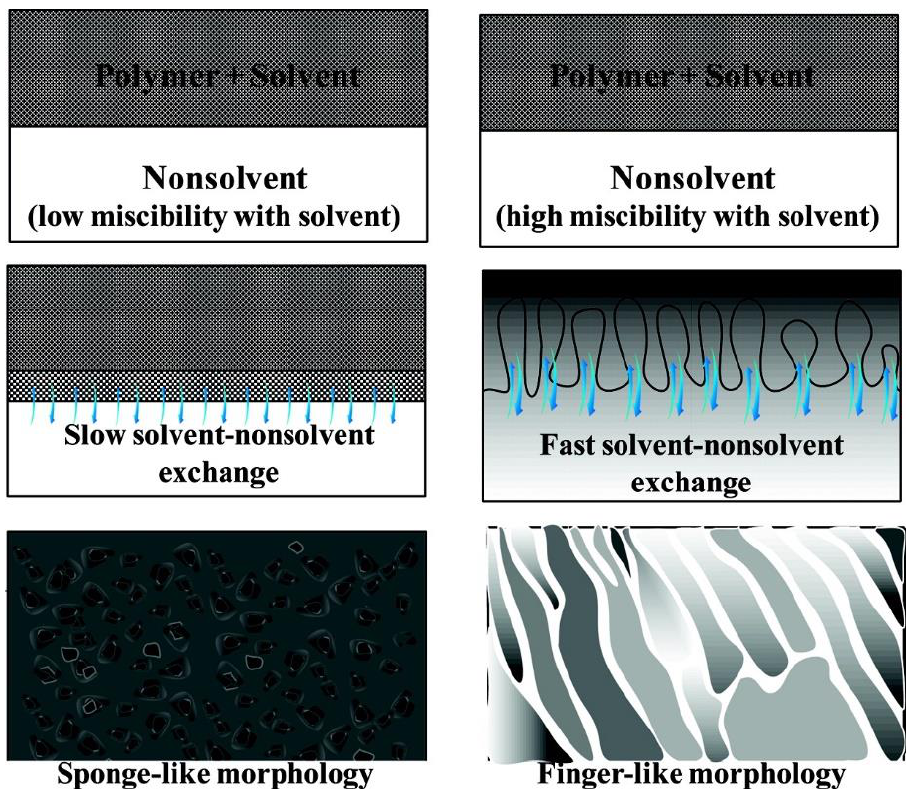
Figure 10. Cross sectional morphologies of membranes formed by instantaneous and delayed de- mixing processes. Reprinted with permission from [16]. Copyright 2011 American Chemical Soci- ety.